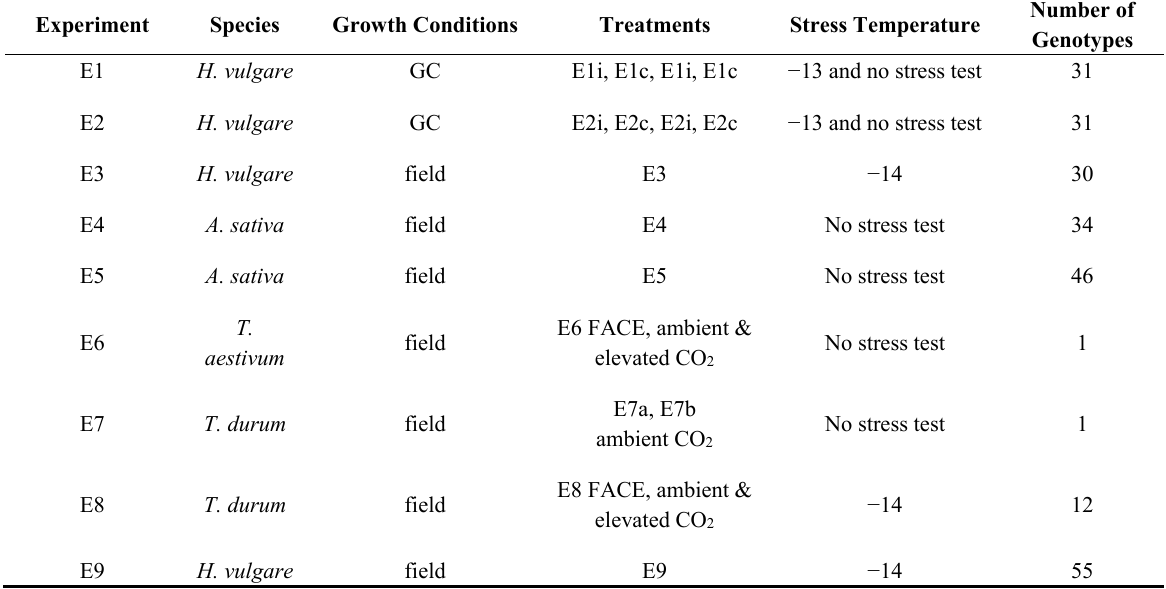
Table 1. Abbreviations for the experiments; studied species; growth conditions: GC = plants grown in growth chambers, field = plants grown in the field and leaves cut for subsequent freezing tests and measurements; Treatments: i = measurements on attached leaves, c = measurements on cut leaves, FACE = Free Air Carbon Dioxide Enrichment; Stress temperature = minimum temperature during freezing stress tests (°C); number of genotypes studied. See Table S1 in the Electronic Supplementary Materials (ESI) for more information on the field